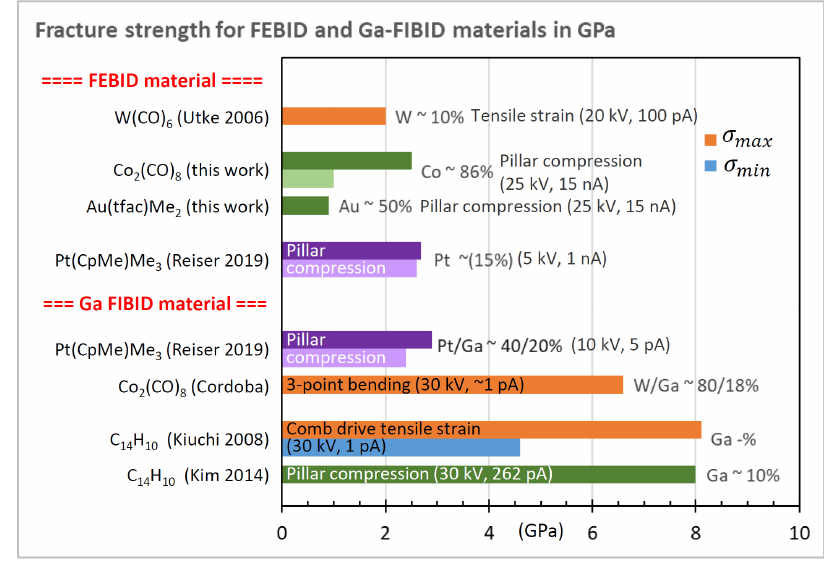
Figure 21. Fracture strengths of as grown FEBID and FIBID structures. The methods are indicated as well as the metal content whenever available from the reference. The precursor molecules and the first authors are listed on the vertical axis. Green colors highlight measurements on large volume structures; other colors indicate measurements on high aspect ratio pillars with potential core–shell internal structure. The purple bars indicate the measured stress at 7% strain and not the fracture stress, which is